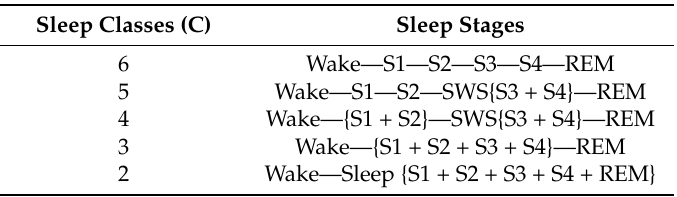
Table 3. Notations used for sleep classes in this work.